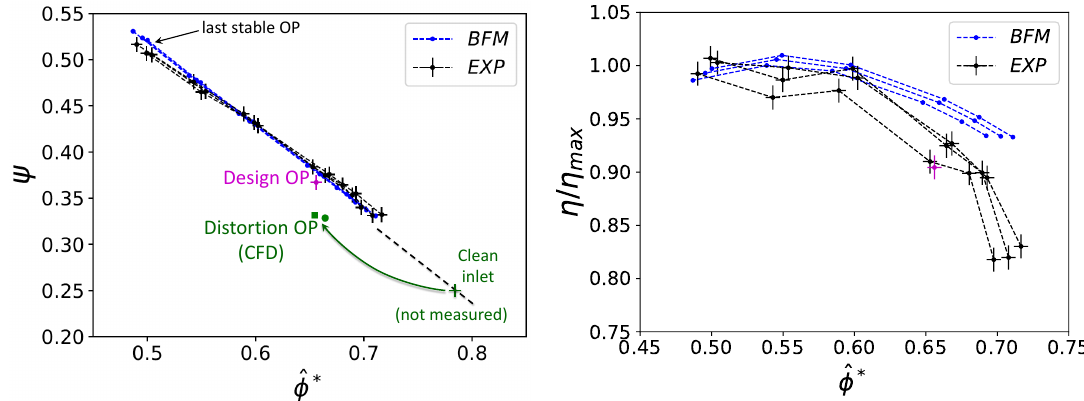
Figure 8. Global performance of the fan stage, clean inlet case, and distorted